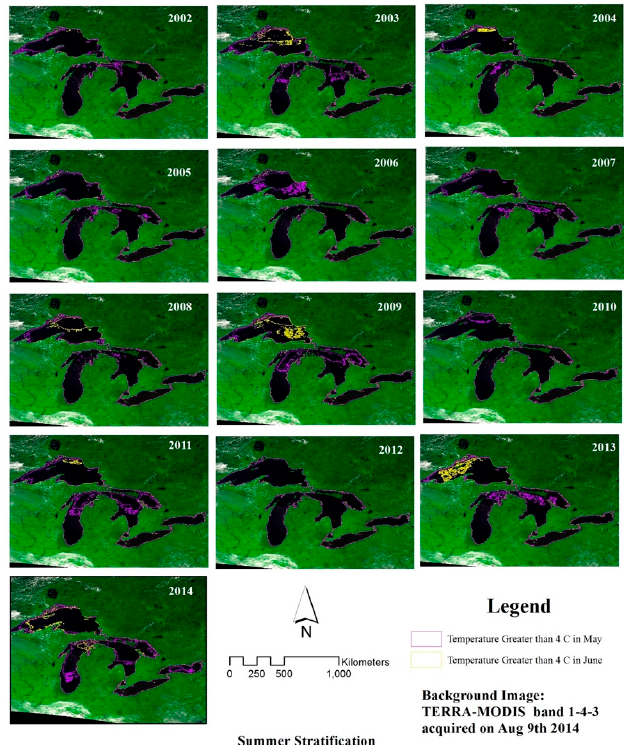
Figure 4. Lake-wide summer stratification evaluated from GLST in May (blue) and June (yellow) monthly means during July 2001 to December 2014 (°C). In the warmer years, stratification began in